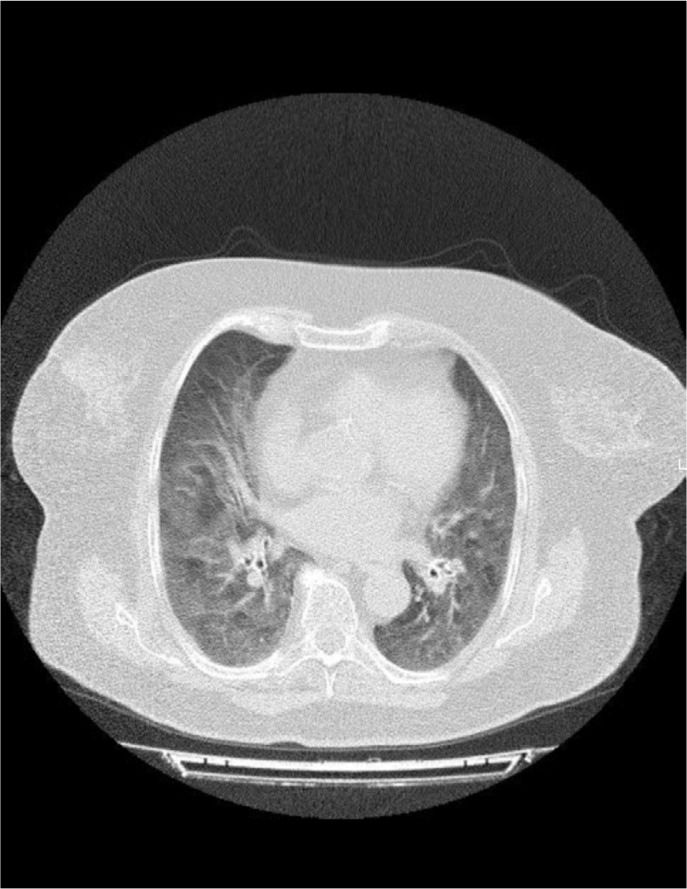
Chest computed tomography at admission showing bilateral ground glass opacities.